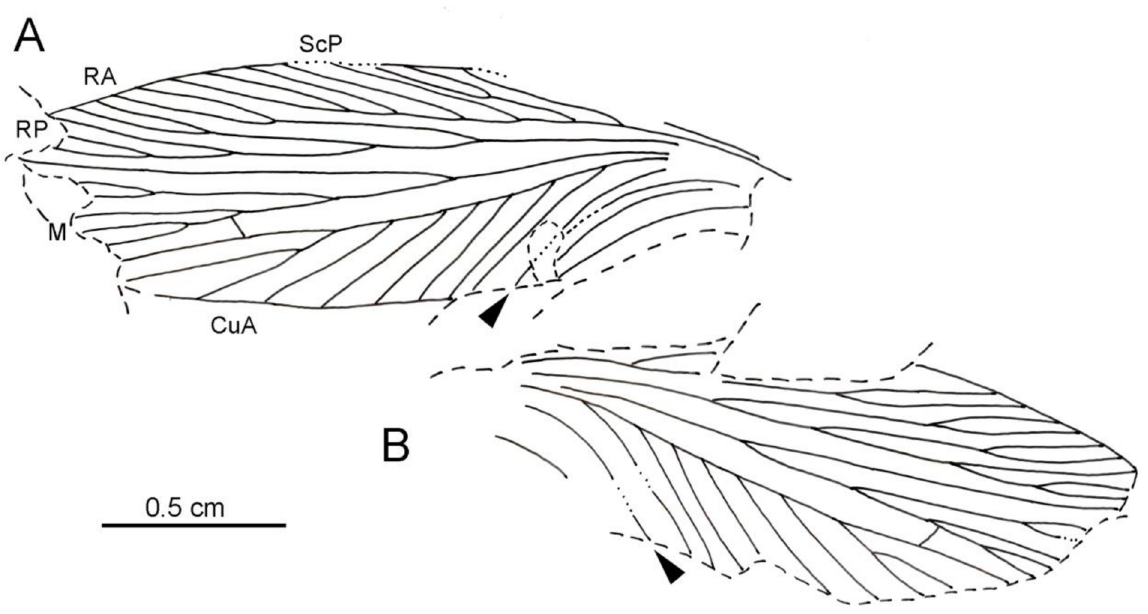
Figure 4. Sysciophlebia ‘sp. form Villablino’ (Spiloblattinidae), MGM-814H, Orallo mine (Villablino, Le ó n Province), forewing venation, camera lucida drawings. ( A ) Part MGM-814Ha. ( B ) Coun- terpart MGM-814Hb. Abbreviations: CuA = cubitus anterior; M = media; RA = radius anterior; RP = radius posterior; ScP = subcosta posterior; arrowheads CuP+PCu cubitus posterior +